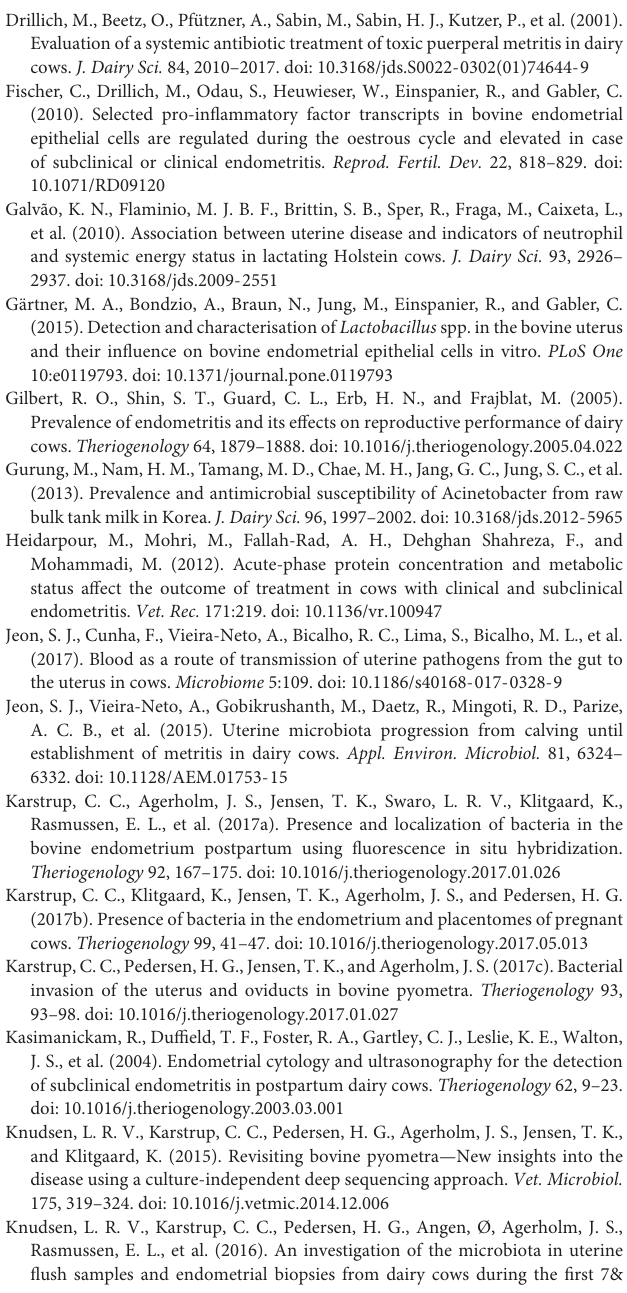
FIGURE S1 | Rarefaction curves of each individual cow. Healthy, healthy cows, n = 13; SE, subclinical endometritic cows, n = 5; and CE, clinical endometritic cows, n = 9. TABLE S1 | The basic information of cows included in this study. TABLE S2 | Key features are statistically different between the uterine microbiota of healthy and clinical endometritic cows. TABLE S3 | Key features are statistically different between the uterine microbiota of healthy and subclinical endometritic cows.